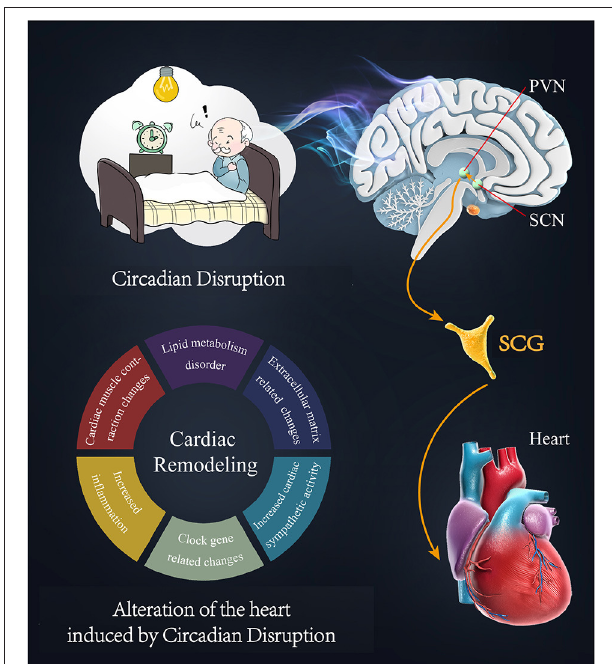
FIGURE 6 | Sympathetic nervous system is the key link between circadian disruption and cardiac remodeling. Circadian disruption aggravates cardiac remodeling after MI possibly by activating sympathetic nervous system. Circadian information may be carried to the heart by the “SCN-PVN-SCG-Heart” sympathetic axis mechanism. Cardiac remodeling at the transcriptional level is aggravated by circadian disruption, and the changes mainly include cardiac local clock, cardiac nervous system, cardiac muscle contraction, extracellular matrix, lipid metabolism, and